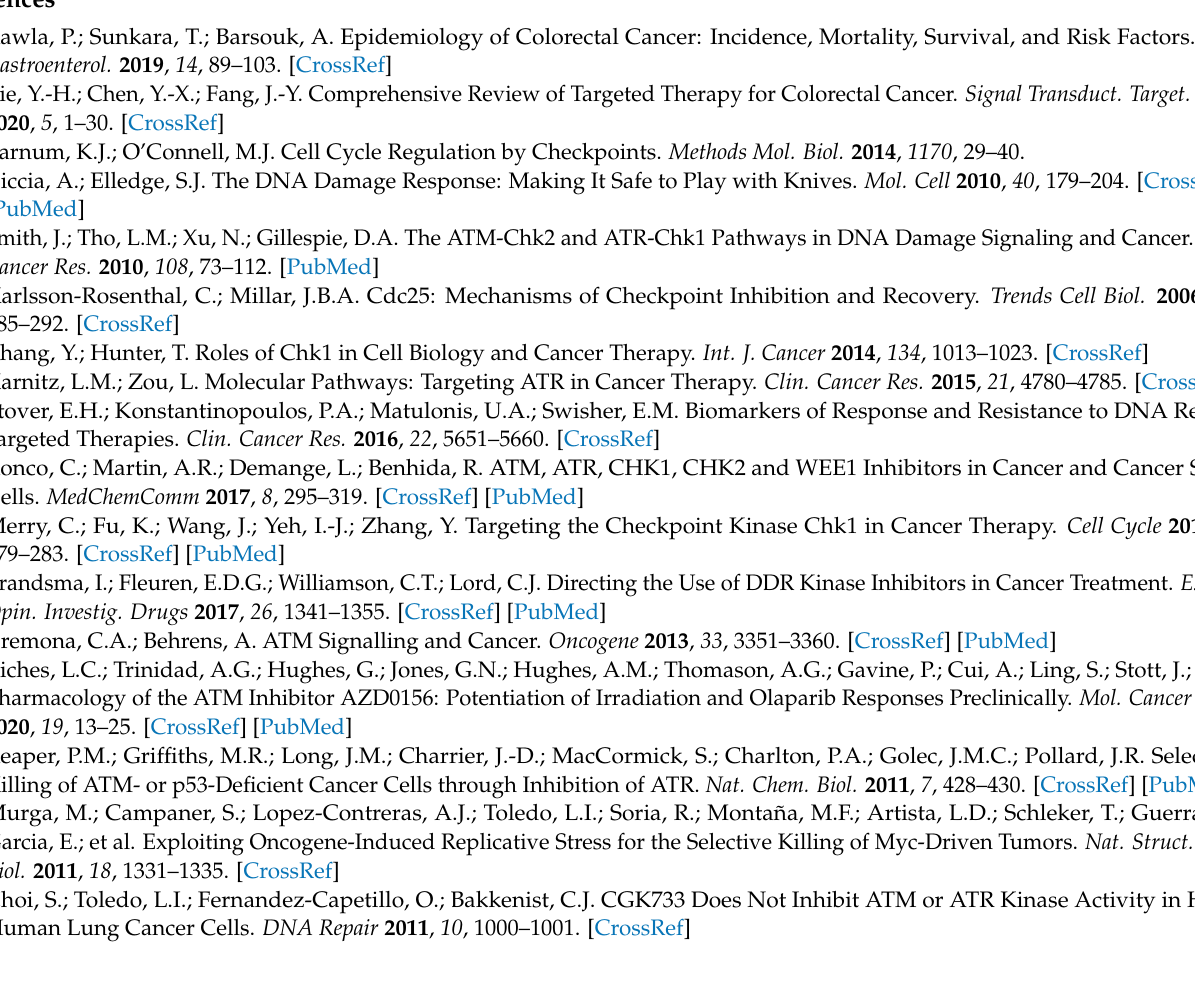
and Chk1i combination; Table S1: Antibodies used in Western blotting analyses; Table S2: IC 50 values of the ATMi and Chk1i treatment; Table S3: CI values for HCT116, DLD-1, HT29, and SF-TY